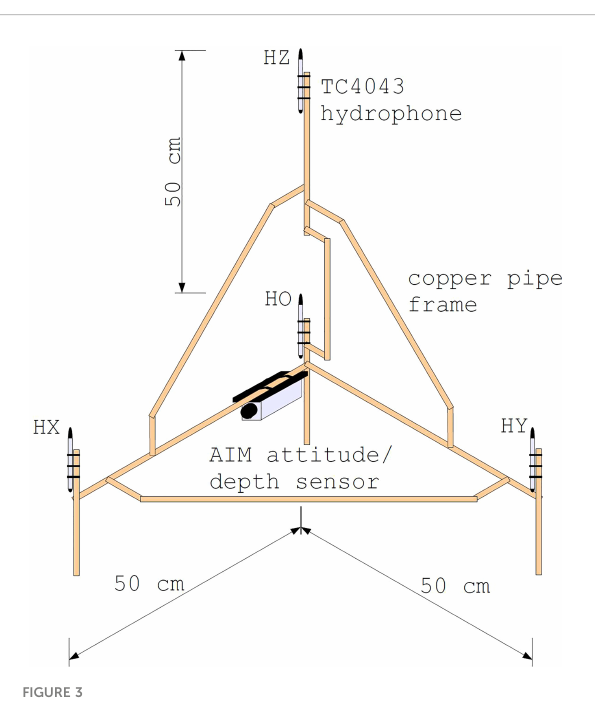
FIGURE 3 Schematic diagram of the pressure gradient sensor shown in isometric projection. Four Reson TC4043 hydrophones are located at the positions indicated HO (origin) HX ( x -axis) HY ( y -axis) and HZ ( z -axis). The JASCO AIM attitude/depth sensor is oriented in the x -direction. The axial hydrophones HX , HY and HZ are all located 50 cm from the origin hydrophone HO .